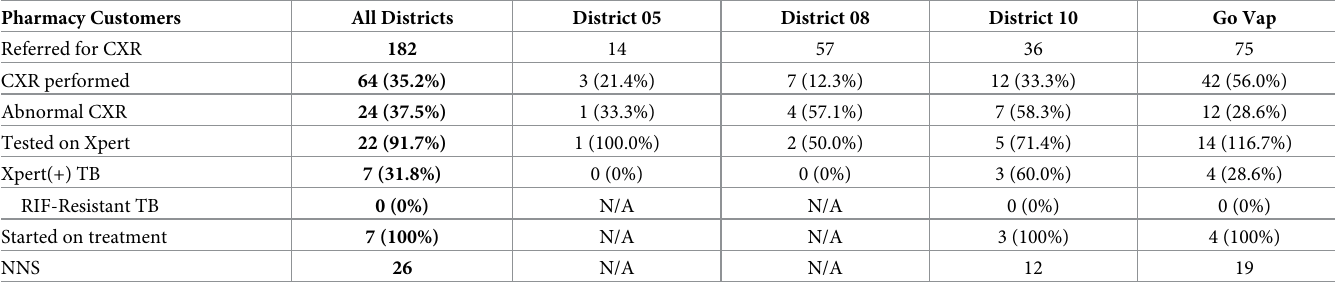
Table 2. TB referral cascade among pharmacy customers by district.